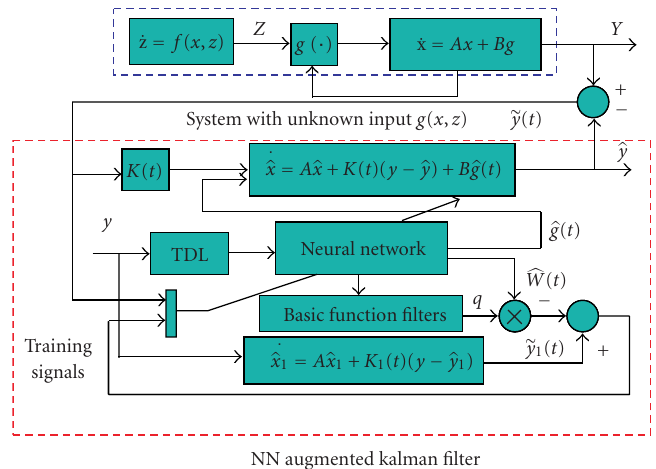
Figure 9: Kalman filter augmented with an adaptive